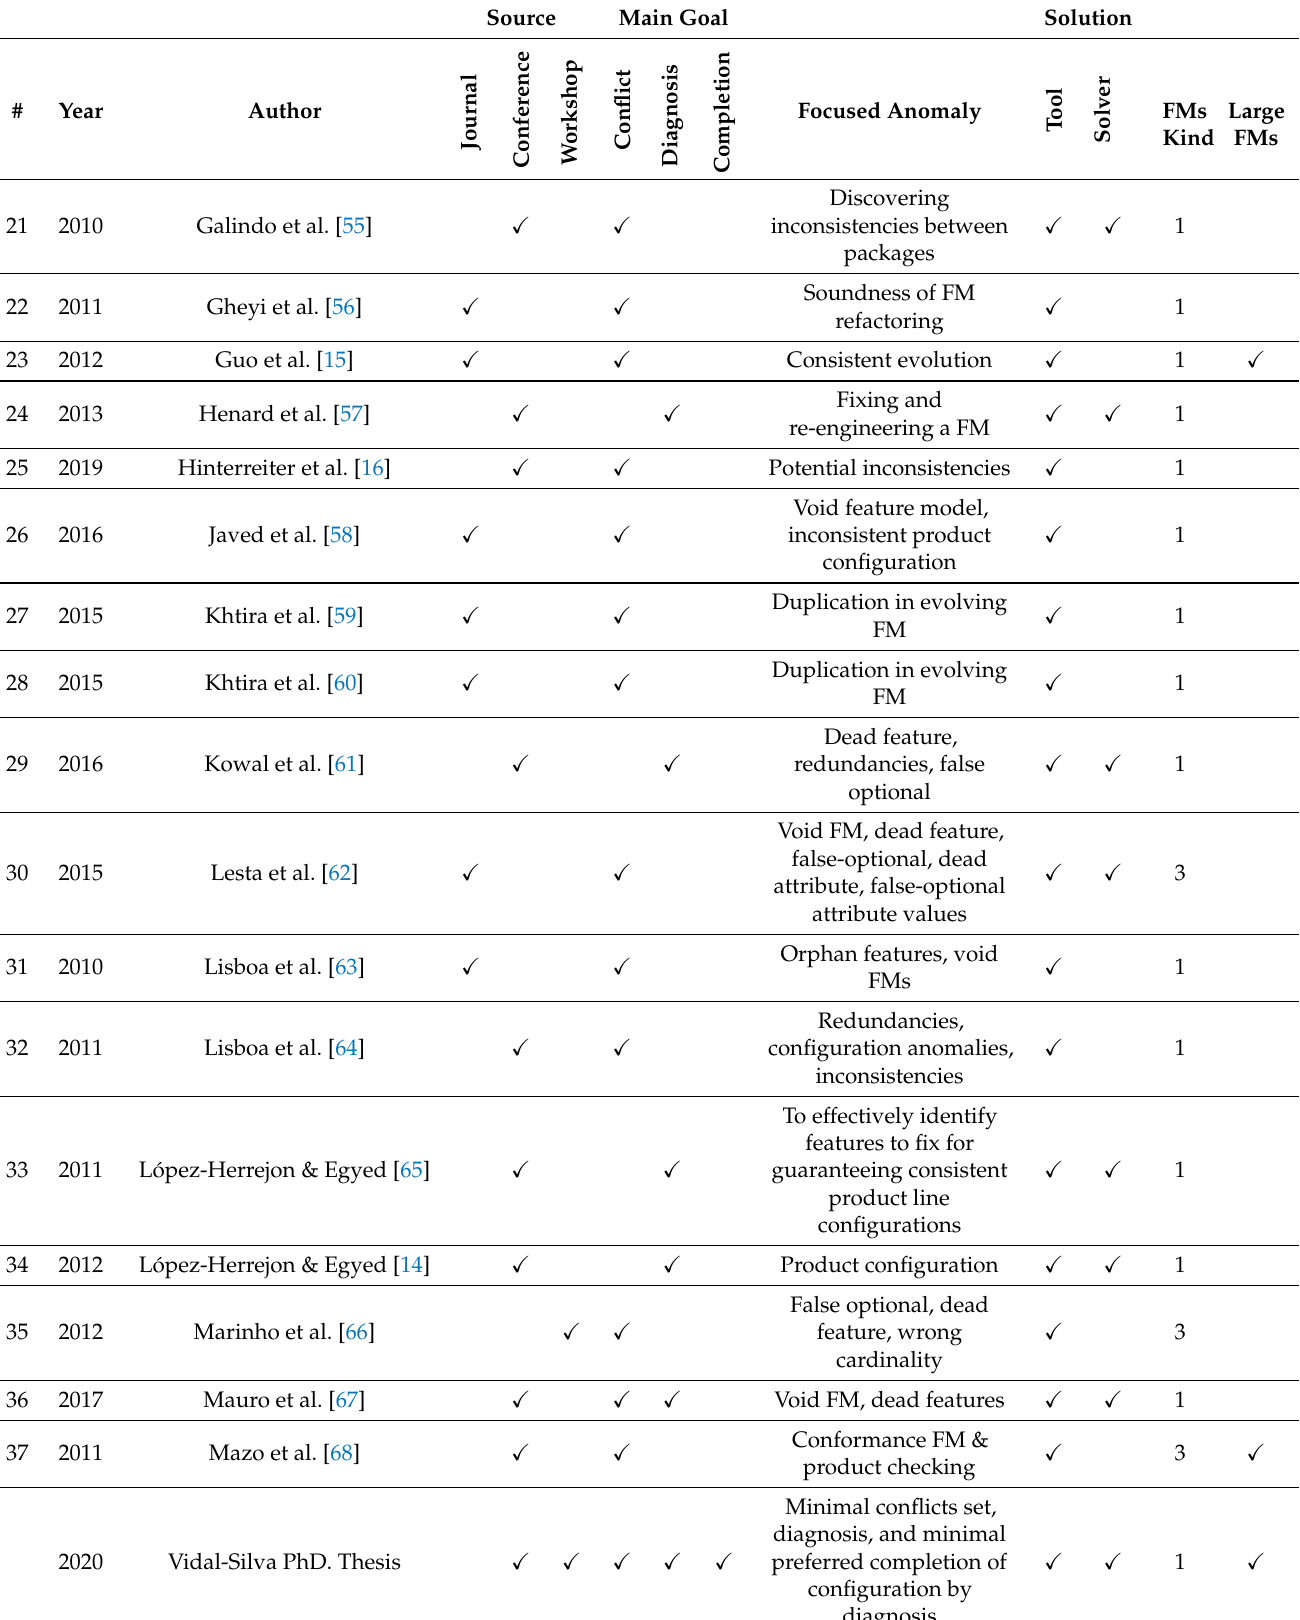
Table 3. List of articles ordered by the authors’ last name from G to M in the SLR vs. our thesis work. Source Main Goal